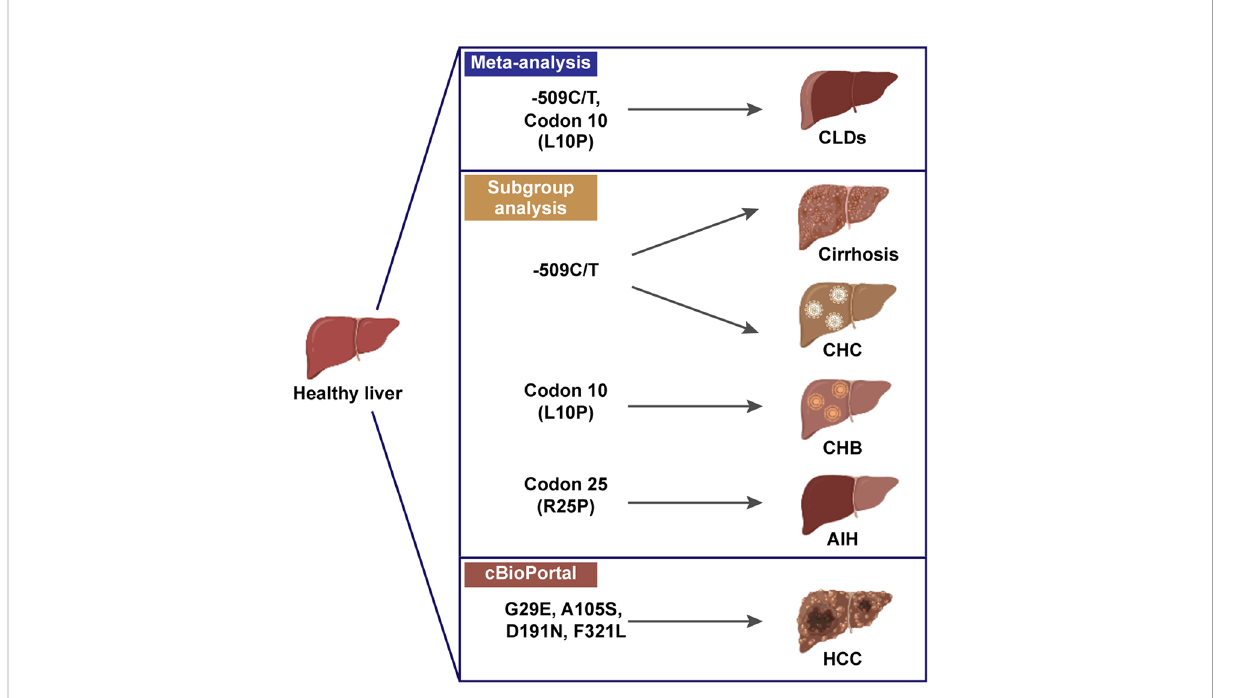
FIGURE 7 Schematic of TGF- b 1 polymorphisms in susceptibility of CLDs, created in